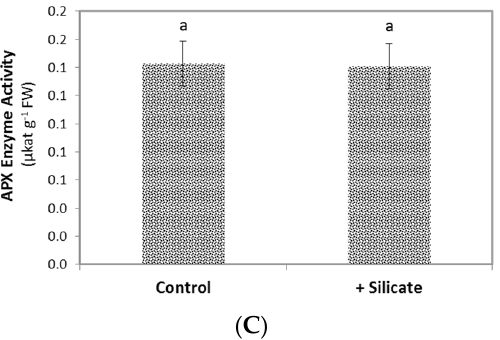
Figure 4. ( A ): PAO (Polyamine Oxidase); ( B ): DAO (Diamine Oxidase); and ( C ): APX (Ascorbate Peroxidase) enzyme activities in leaves of control and Si-treated cucumber plants. Values are means ± SD and different letters above the bars indicate significant difference between the treatments (Tukey post hoc: p < 0.05); n = 8.